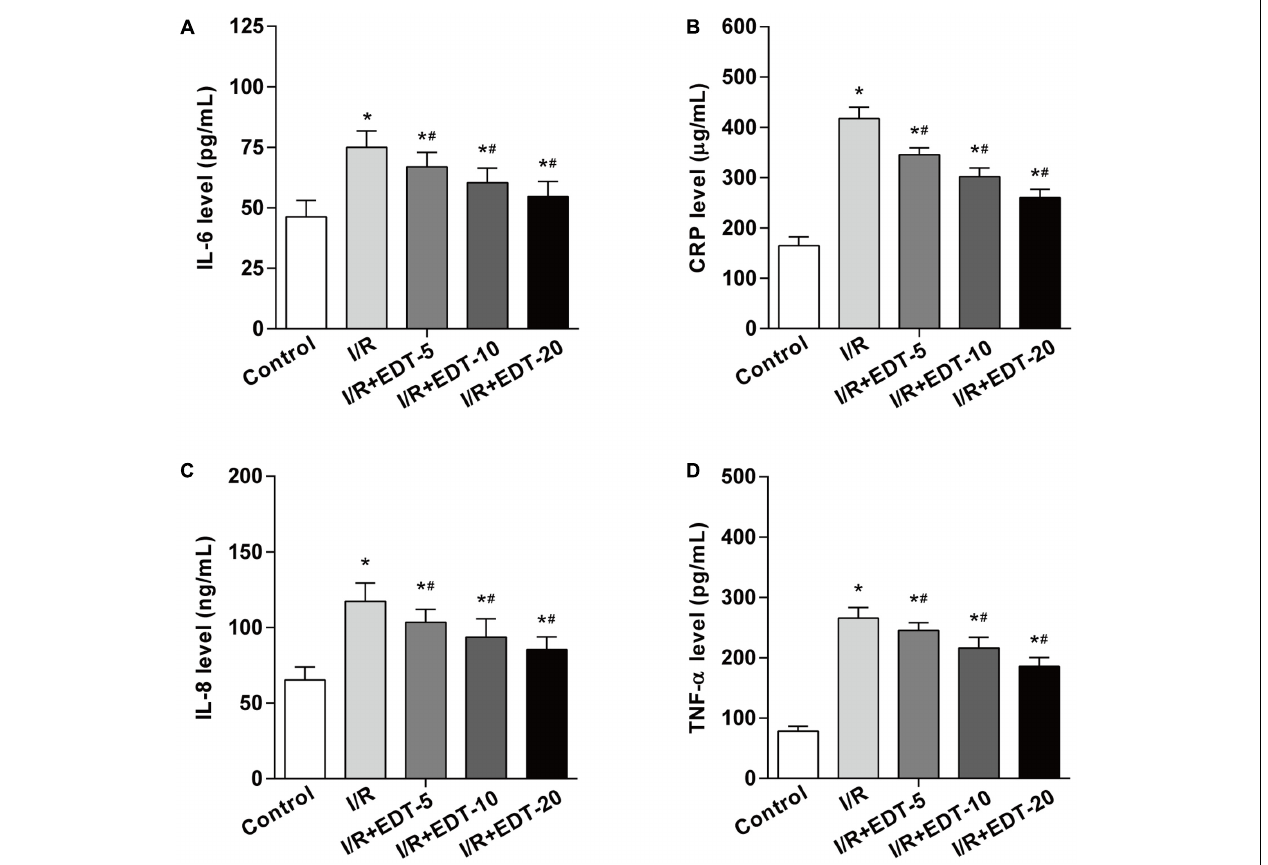
FIGURE 2 | Eriodictyol treatment suppresses the elevated levels of IL-6, CRP, IL-8, and TNF- α induced by I/R. The effect of EDT on IL-6 (A) , CRP (B) , IL-8 (C) , and TNF- α (D) levels in cardiac tissues were measured by ELISA kits. n = 8 for each group. All data are the mean ± SD. ∗ P < 0.05 compared with control group, # P < 0.05 compared with I/R